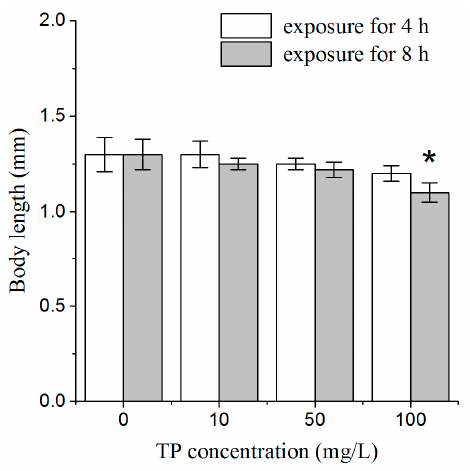
Figure 2. Comparison of body length in nematodes exposed to TP for 4 and 8 h. TP, Triptolide. Bars represent means ± SEM. * p < 0.05 vs. the control group.